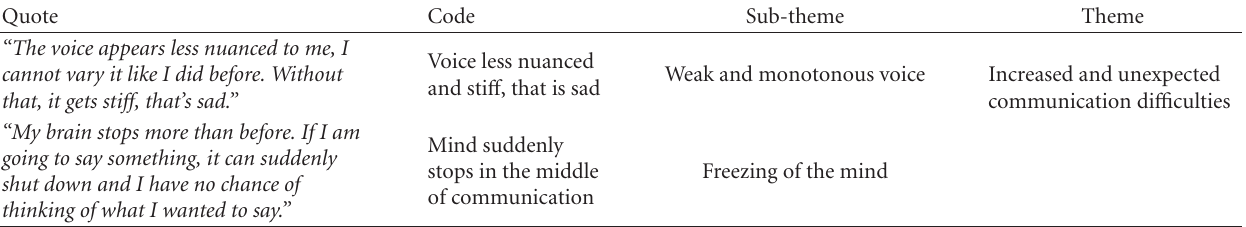
Table 2: The emergence of the theme “increased and unexpected communication di ffi culties”.